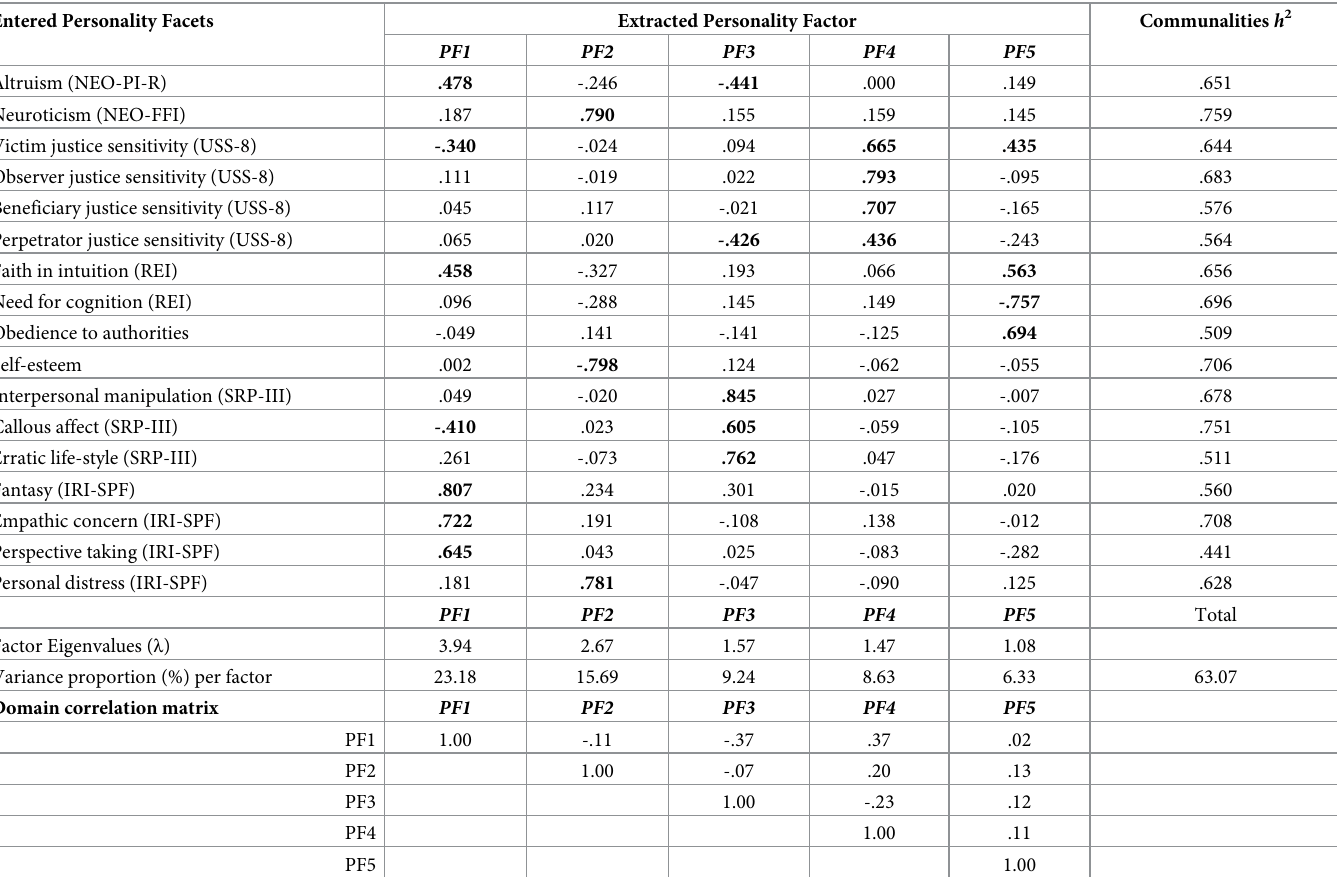
Table 1. Results of exploratory factor analysis.